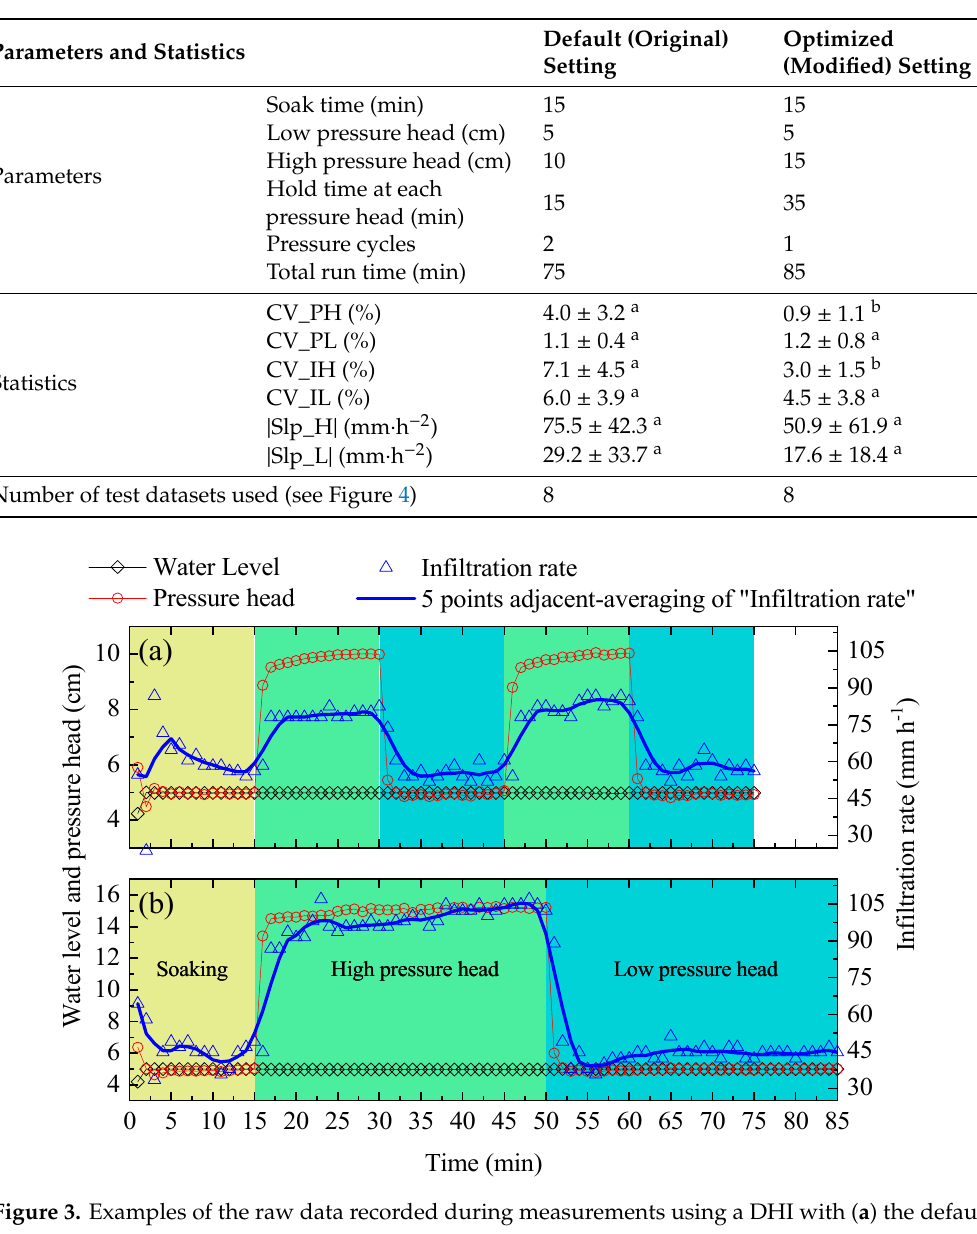
Table 2. Characteristics of eight infiltration processes with di ff erent measurement settings (default vs. optimized). CV_PH and CV_PL are the coe ffi cients of variation (CV) for high and low pressure heads, respectively. CV_IH and CV_IL are the CVs for infiltration rates at high and low pressure heads, respectively. | Slp_H | and | Slp_L | are the absolute values of the linear regression slopes of the infiltration rate over time at high and low pressure heads, respectively. Di ff erent letters indicate a significant di ff erence at α = 0.05.